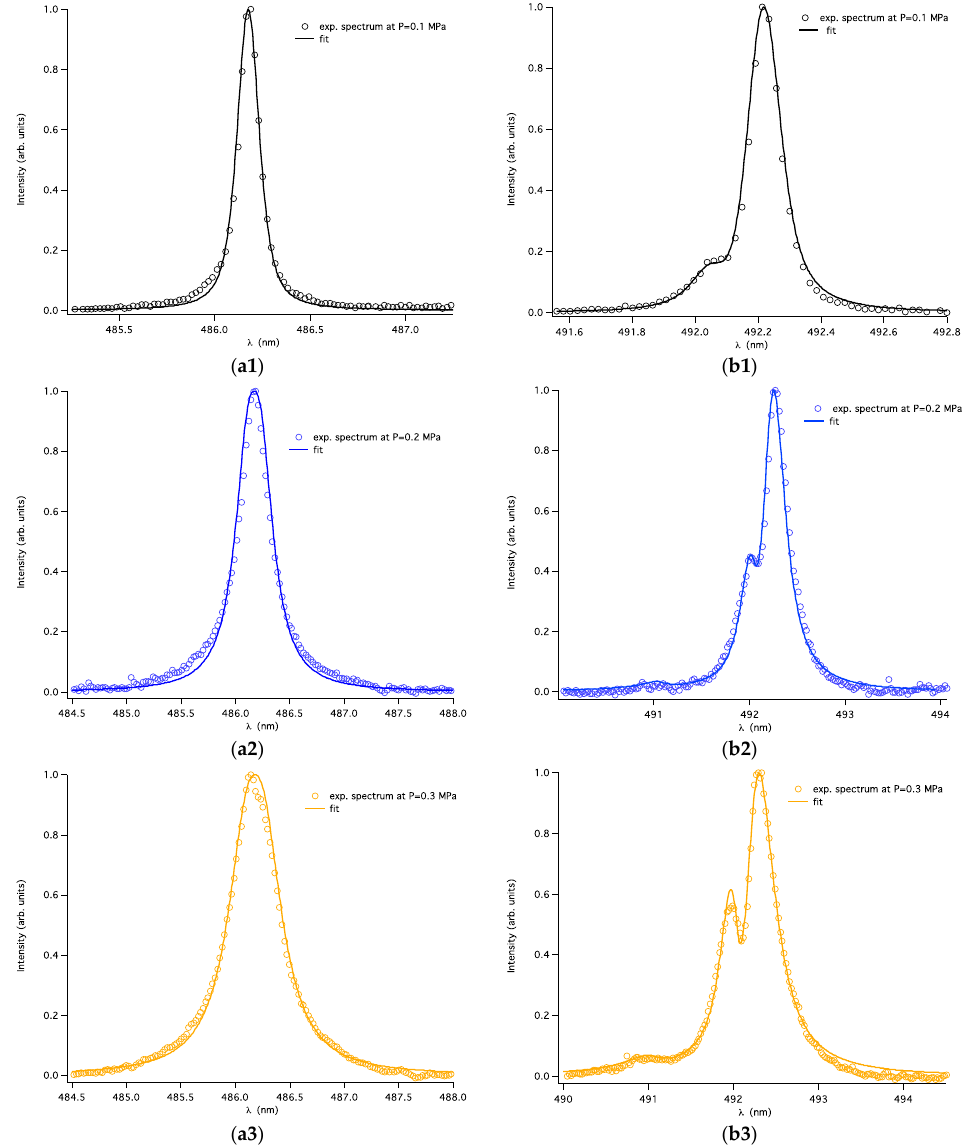
Figure 6. Examples of fitting of the experimental spectral lines. ( a ) H-β line profile ( b ) He I 492 nm line profile for pressure value (1) 0.1 MPa (2) 0.2 MPa (3) 0.3 MPa